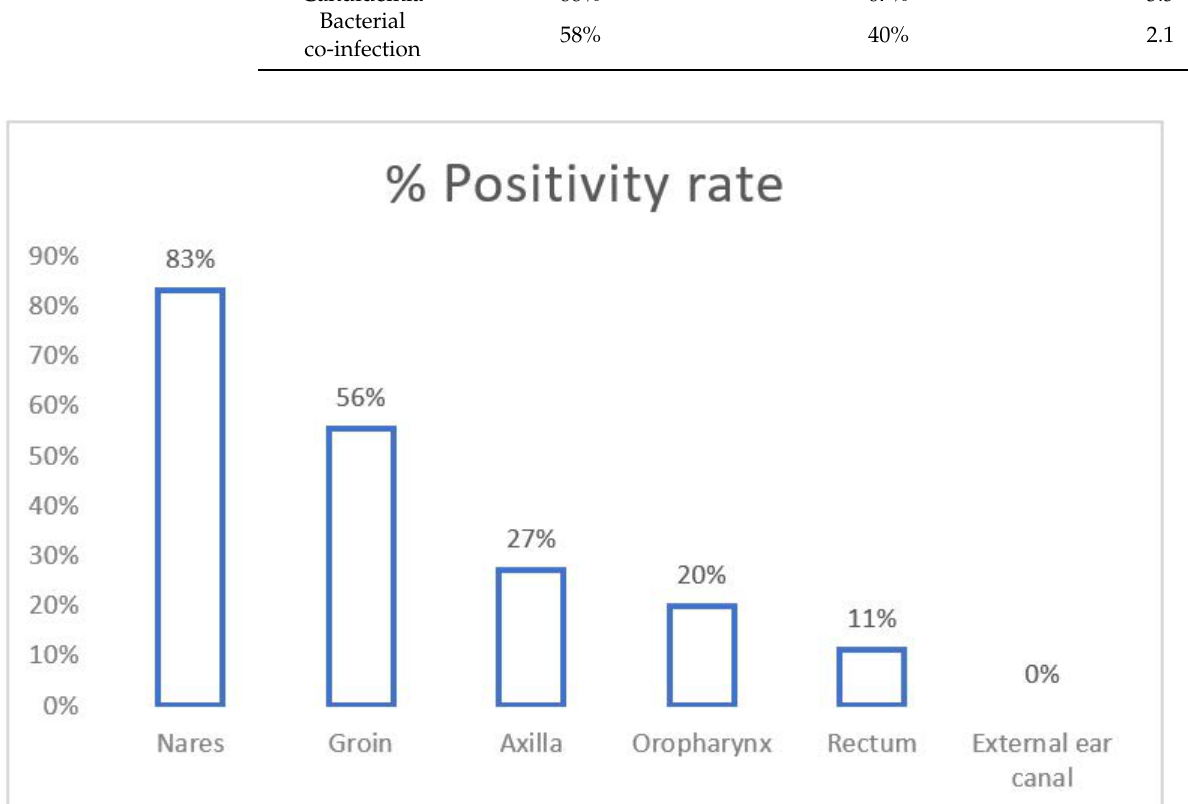
Figure 2. Positivity rate (%) of various samples for screening of Candida auris colonization in patients. Screening of patient contacts: The contacts of 18 patients (33%) were screened for